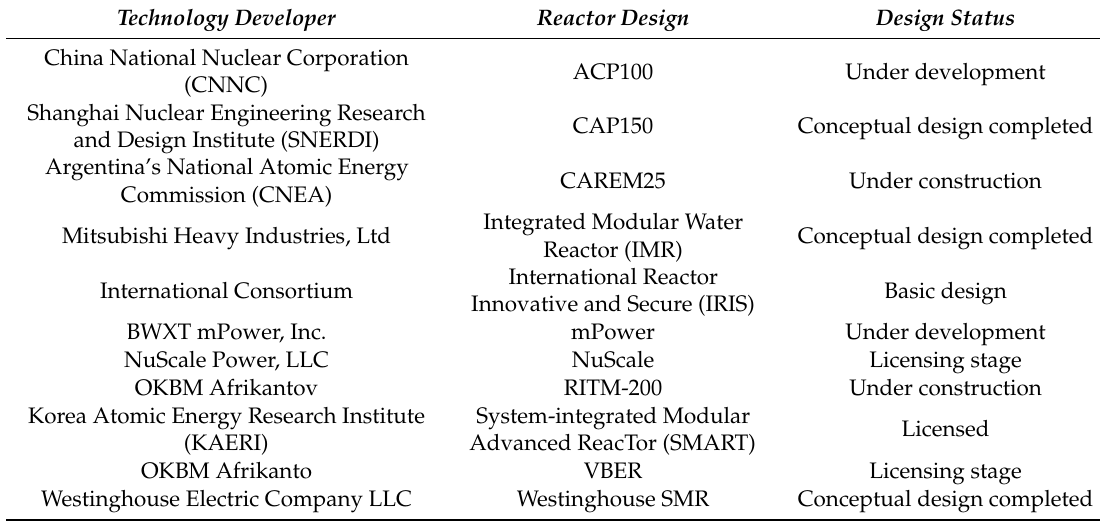
Table 1. Current integral pressurized water reactor (iPWR)-type small modular reactor (SMR) designs and status.